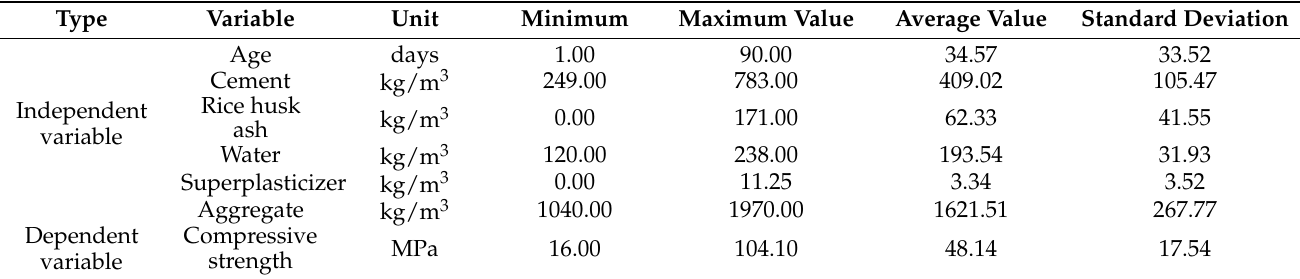
Table 3. Statistics of the RHA dataset (data source: [46]).